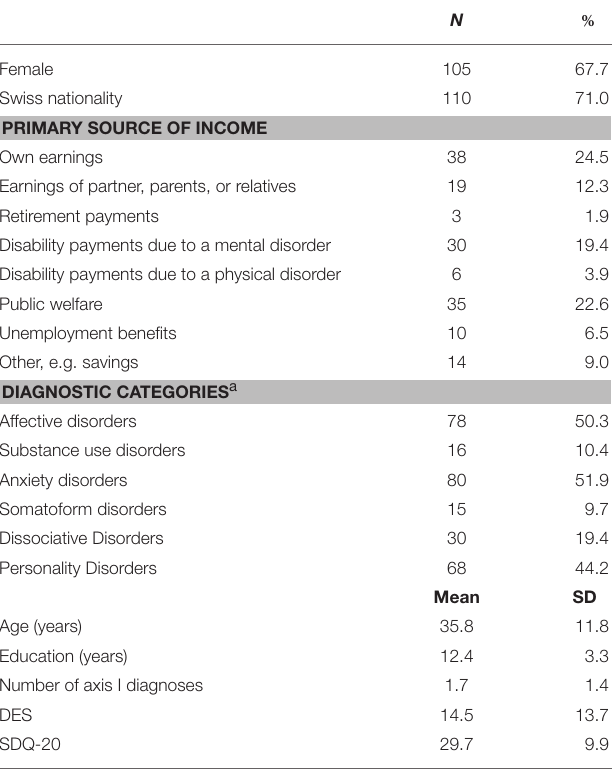
TABLE 1 | Sociodemographic and clinical characteristics at baseline of outpatient and daycare patients ( N =